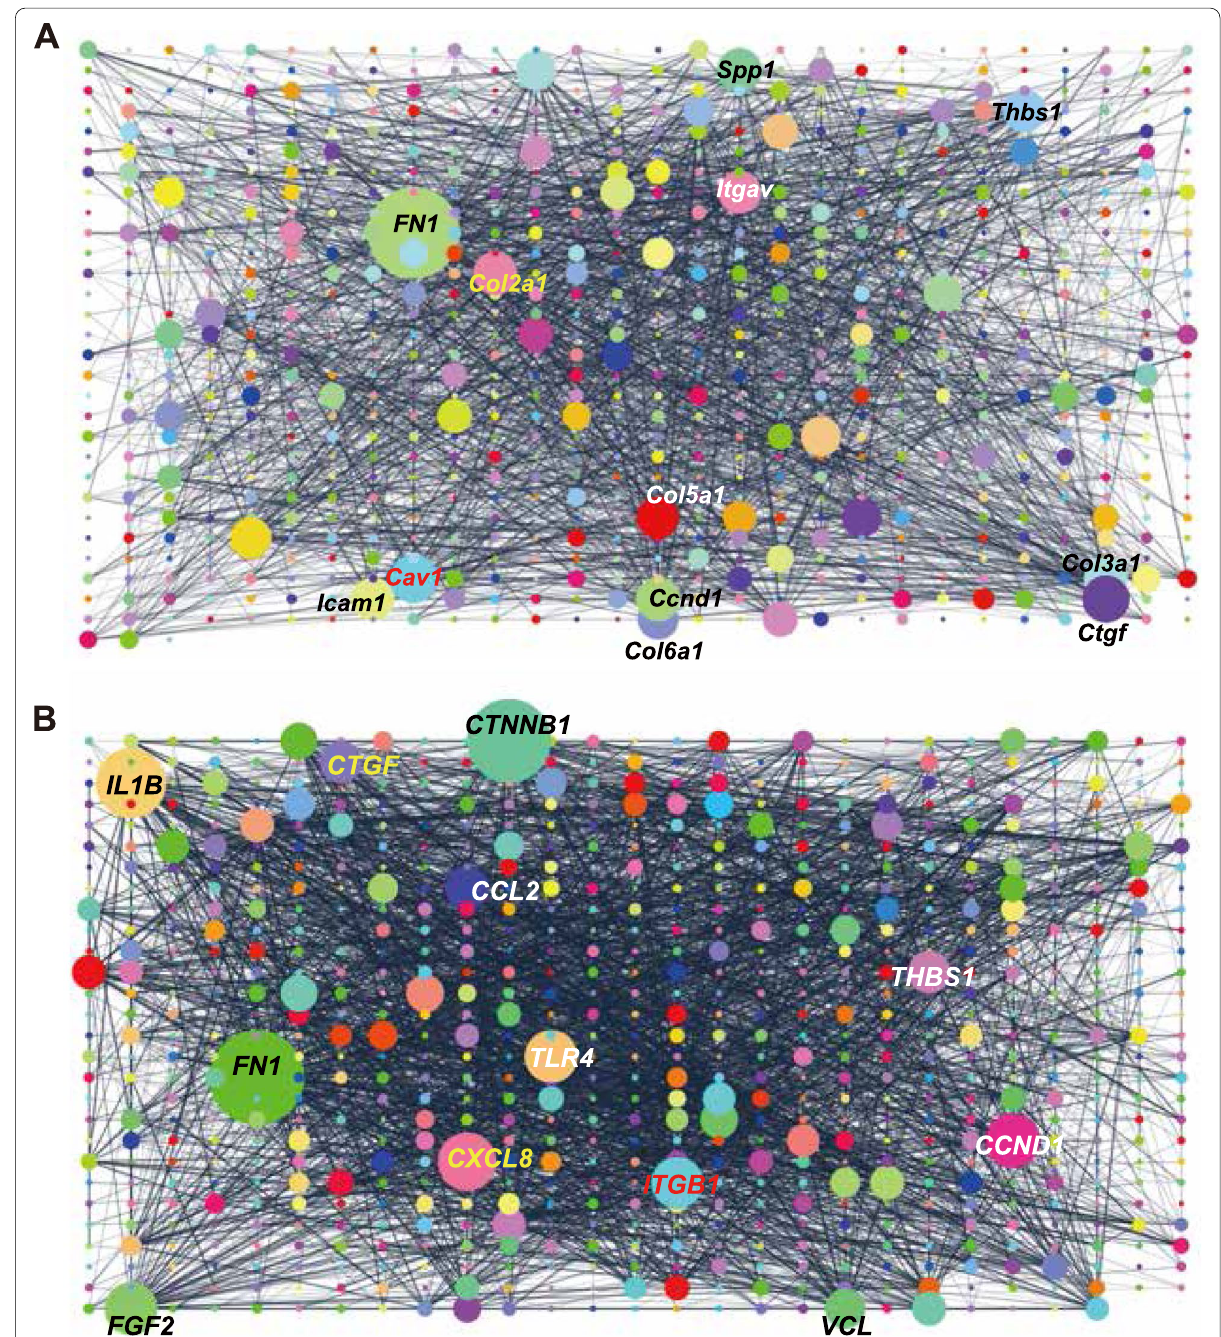
Fig. 5 Hub genes in mouse and human COL sphere identified in gene network analysis,. A , B Mouse COL gene set (padj<0.05, FC MG‑ENR ( A ) and Human COL gene set (padj<0.05, FC 2) compared to MG organoids ( B ) was analyzed in Cytoscape software using the String app. ≥ Each circle represents a hub node and the diameter of the circle corresponds with the degree of each node. Top 12 largest nodes are indicated